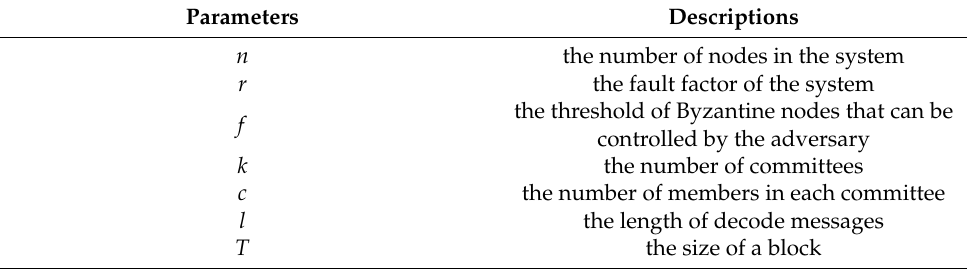
Table 2. Descriptions of the notations mentioned in this paper. Parameters